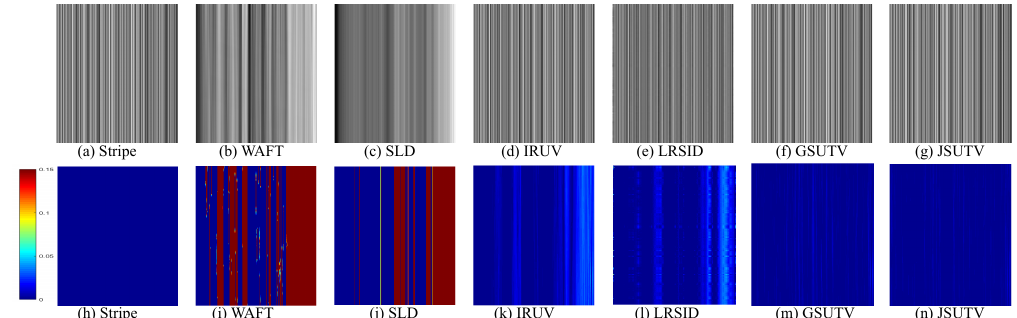
Figure 7. The estimated stripe of Case 3. ( a ) The true stripe. Estimated stripe images by ( b ) WAFT, ( c ) SLD, ( d ) IRUV, ( e ) LRSID, ( f ) GSUTV, and ( g ) JSUTV. The corresponding error images of ( h ) the true stripe,